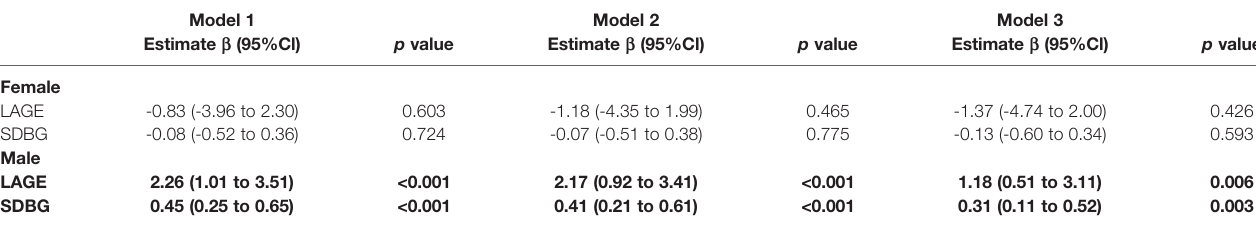
TABLE 2 | Association of low muscle mass with glucose fl uctuations (LAGE and SDBG) among participants with type 2 diabetes receiving CSII